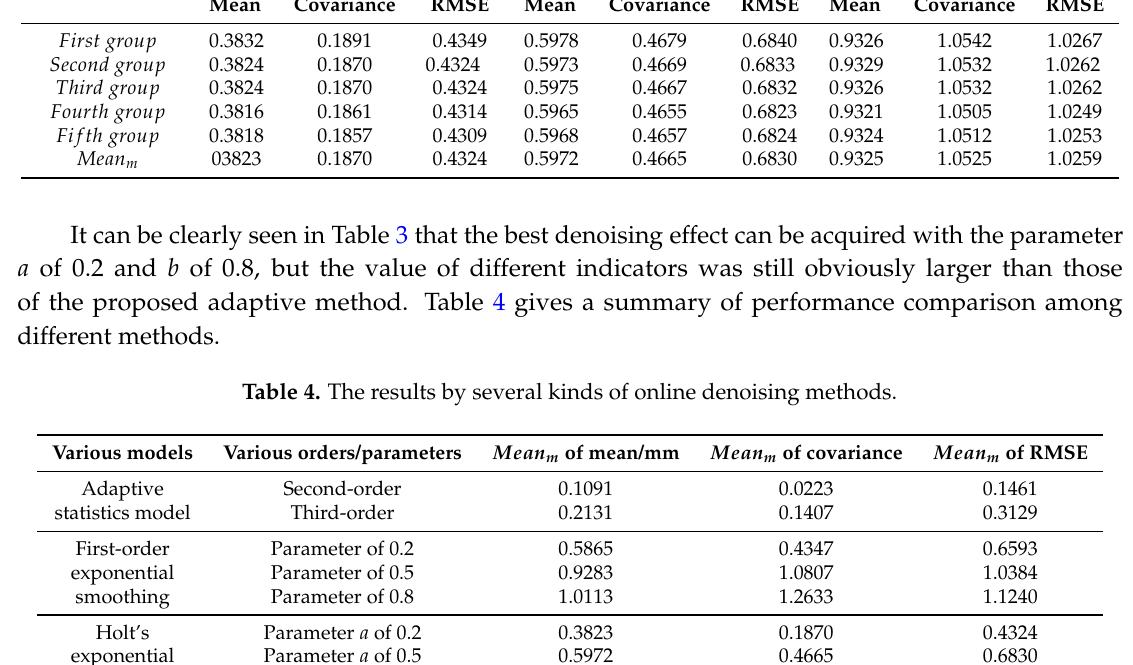
Table 3. Mean, covariance and RMSE the of Holt’s exponential smoothing with different parameter a . Various Models